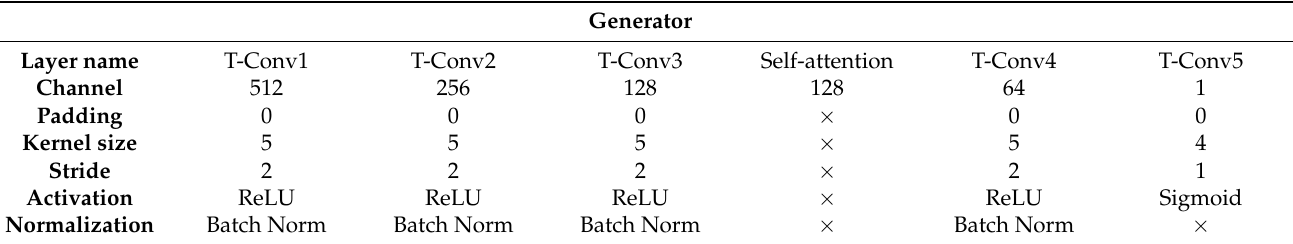
Table 2. The structure and parameters of the